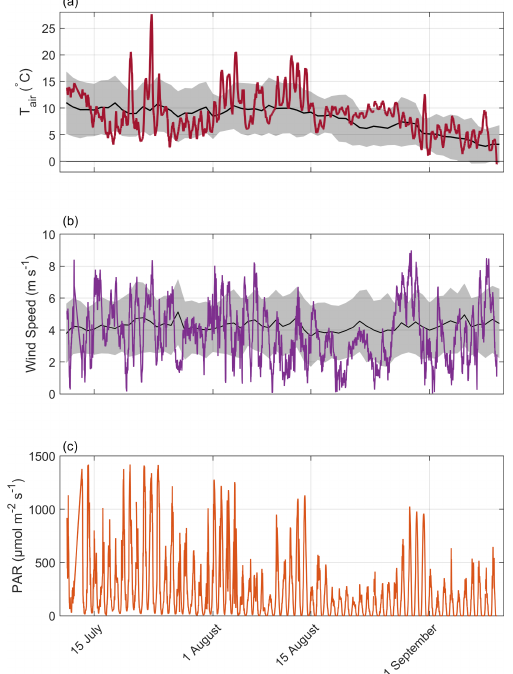
Figure A2. Timeline of observed meteorological conditions during the observation period (2019) with air temperature at 2m height (a) , wind speed at 3m height (b) , and photosynthetically active radiation (PAR) (c) . Mean values and standard deviation of observations during the past 16 years are plotted as black lines and gray areas.